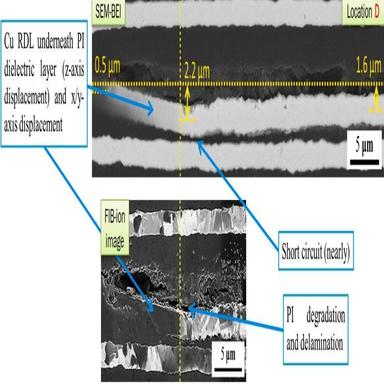
Top-view backscattered (SEM-BEI) and FIB ion-imaging microstructures of the failed Cu interconnect, corresponding to the confined location D in, after the electromigration experiment. (1.5-column; Color online). (For interpretation of the references to color in this figure legend, the reader is referred to the Web version of this article.)